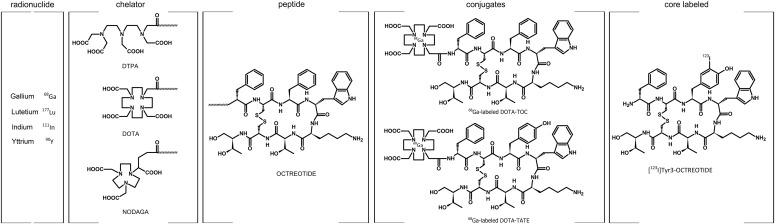
Structures of SST ligands used for scintigraphy. [123I]Tyr3-octroeotide, the very first compound for SST-targeted scintigraphy. Conjugation of DTPA to octreotide and labeling with indium-111 resulted in Octreoscan (Mallinckrodt), the first approved SST agent for SPECT imaging. Advanced Accelerator Application recently received market authorization for 68Ga-labeled DOTA-TOC (SomatoKit TOC) by the European Medicines Agency and for 68Ga-DOTA-TATE (Netspot) by the FDA. It is expected that [177Lu]DOTATATE will soon be approved by FDA and European Medicines Agency as first agent for peptide receptor radiotherapy.